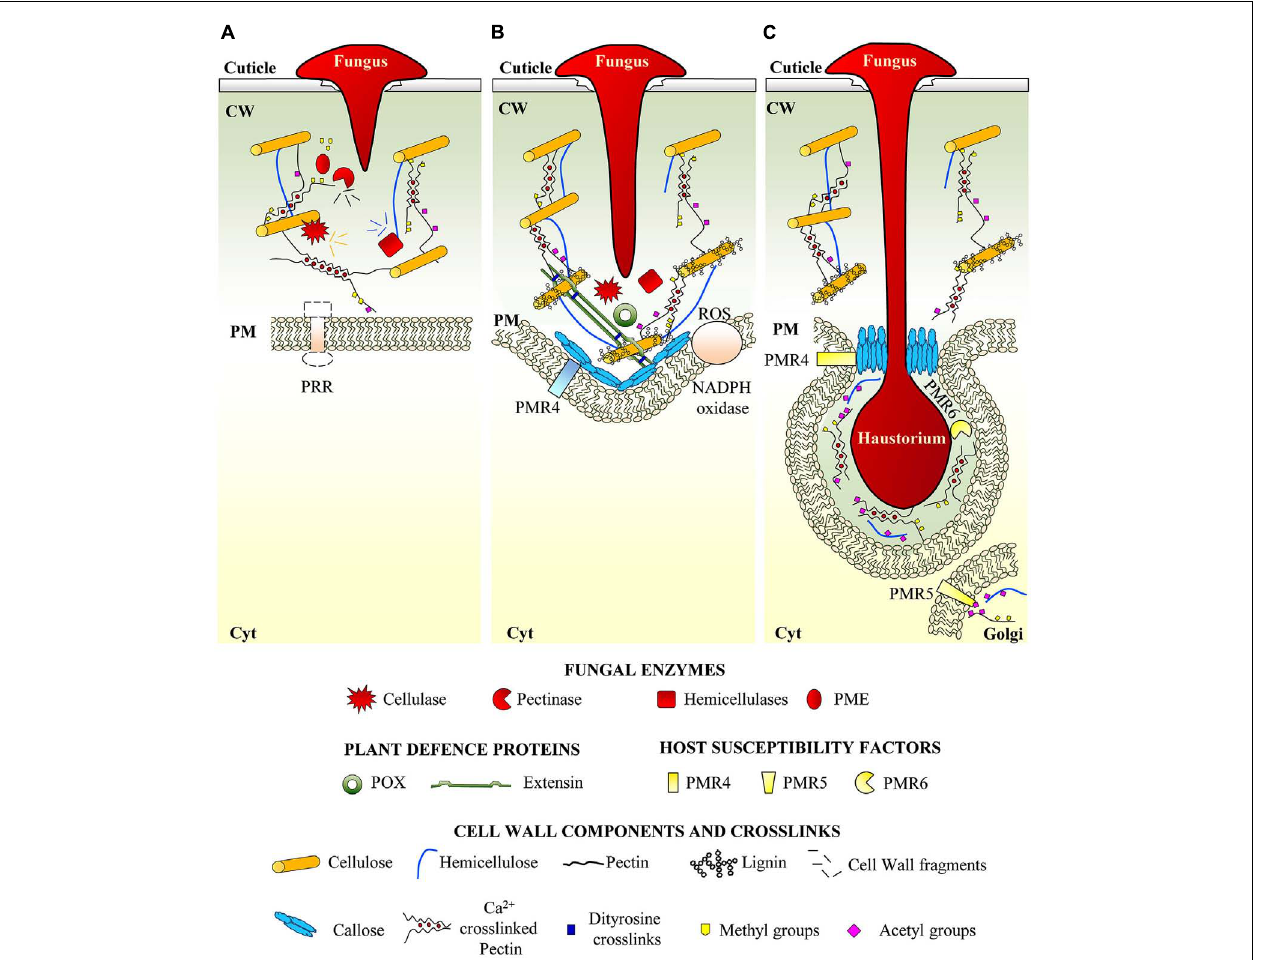
FIGURE 2 | Cell wall dynamics in plant-biotrophic fungi interaction. (A) Biotrophic fungi use appressorial mechanical pressure and secrete cell wall degrading enzymes to penetrate plant cell wall. (B) Plants perceive fungal biotrophs penetration with not yet identified receptors and respond with “papillae” apposition between cell wall and plasma membrane. Papillae, in addition to new cell wall material are also sites of accumulation of ROS possibly involved in cell wall reinforcement. (C) At a later stage of infection, fungus forms the haustorium feeding organ invaginated into the host